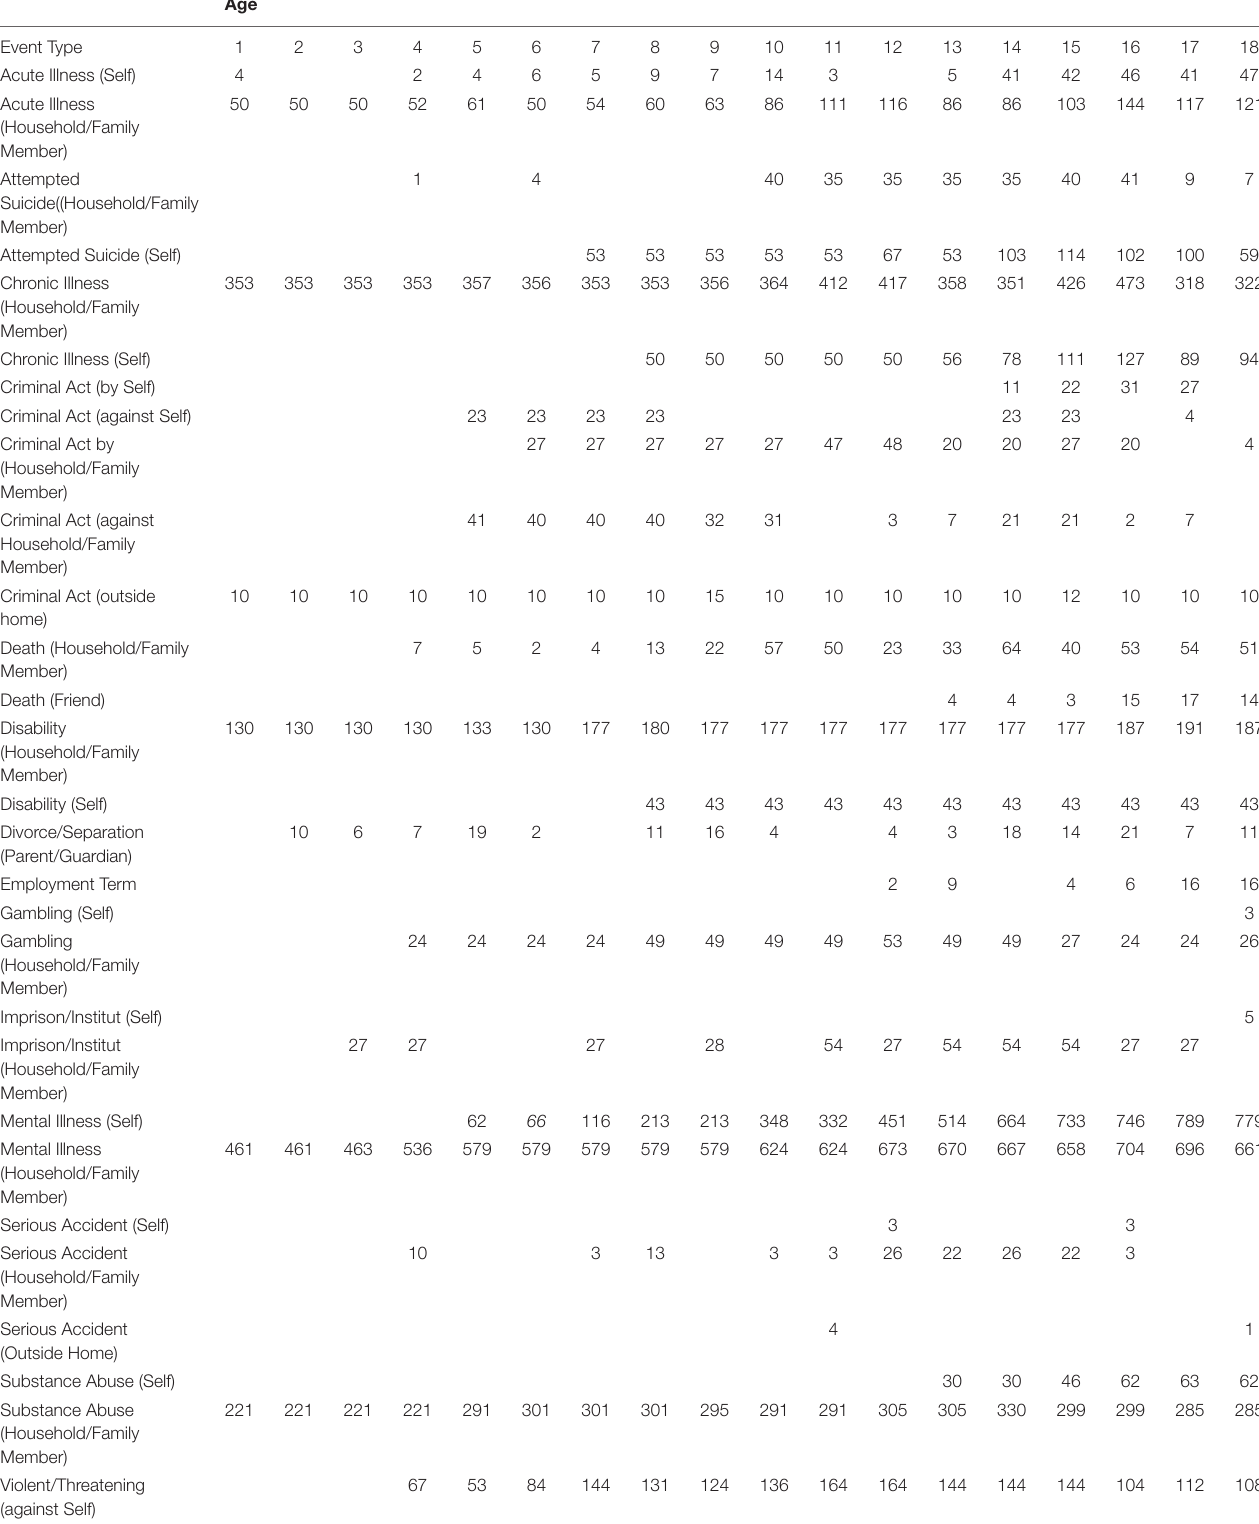
TABLE 2 | Childhood subjective distress by